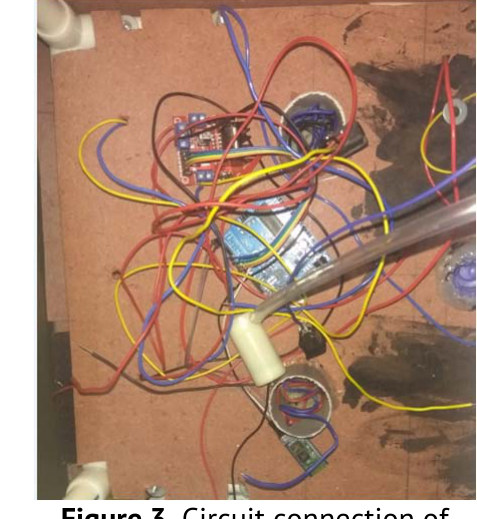
Figure 3. Circuit connection of proposed